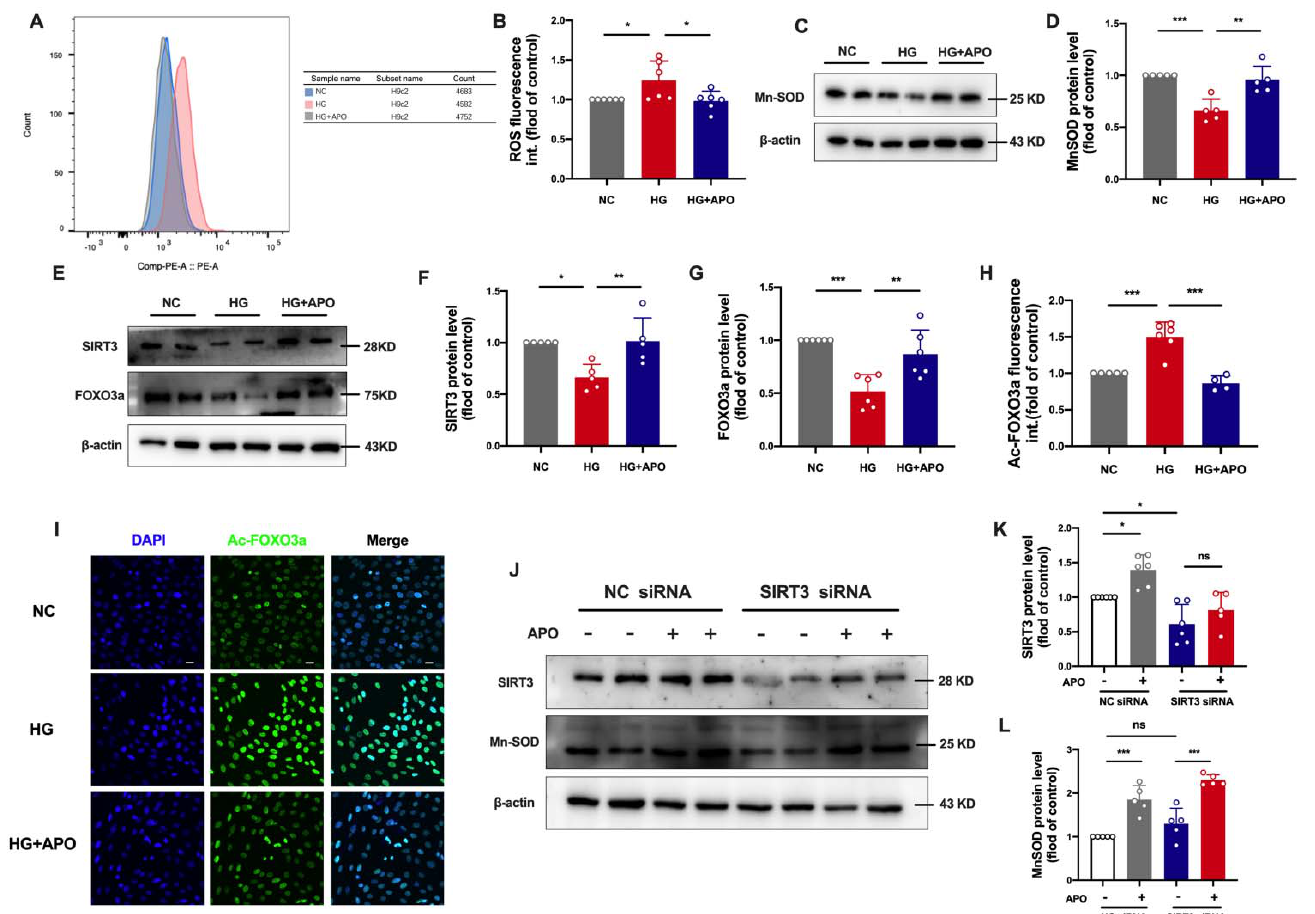
Figure 5. Apocynin (APO) attenuates oxidative stress via the SIRT3/FOXO3a pathway in H9c2 cells. ( A ) H9c2 cells were exposed to normal glucose (NC) or high glucose (HG) or HG with APO for 36 h. Flow cytometry detected H9c2 cells stained with Dihydroethidium (DHE). ( B ) Quantification of ROS by DHE intensity in ( A ). ( C ) Mn ‐ SOD protein level in H9c2 cells detected by Western blot analysis. ( D ) Quantification of Mn ‐ SOD protein level in ( C ). ( E ) The protein levels of SIRT3 and FOXO3a in each group. ( F , G ) Quantification of SIRT3 and FOXO3a protein level in ( E ). ( H ) Ac ‐ FOXO3a fluorescence intensity quantification in ( I ). Scale bar, 20 μ m. ( I ) Representative confocal microscopy images of immunofluorescence staining for Ac ‐ FOXO3a and DAPI in H9c2 cells exposed HG with or without APO. ( J ) Expression of SIRT3 and Mn ‐ SOD in NC siRNA and SIRT3 siRNA with or without APO. ( K , L ) Quantification of SIRT3 and Mn ‐ SOD protein level in ( J ). Data are mean ± SD; n = 4 for 6 independent experiments; * p < 0.05, ** p < 0.01, *** p < 0.001.